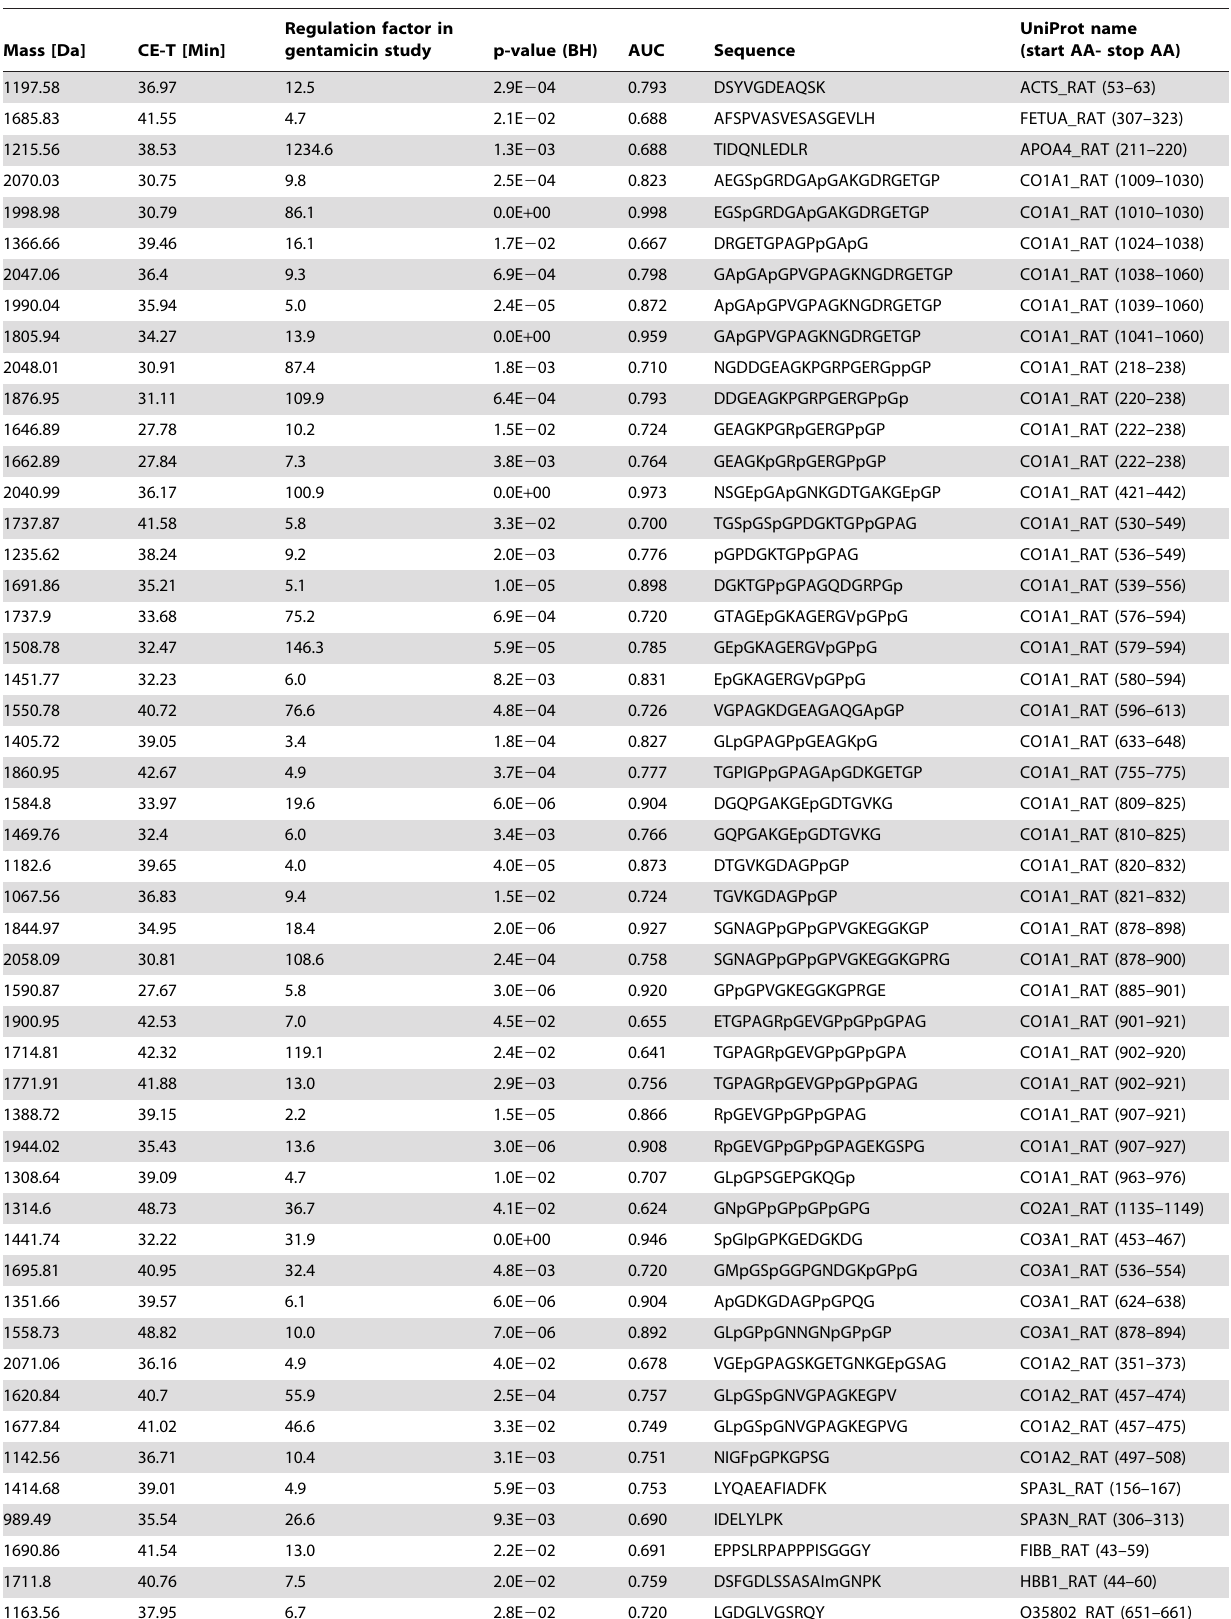
Table 1. Sequenced urinary biomarkers for drug induced kidney injury.